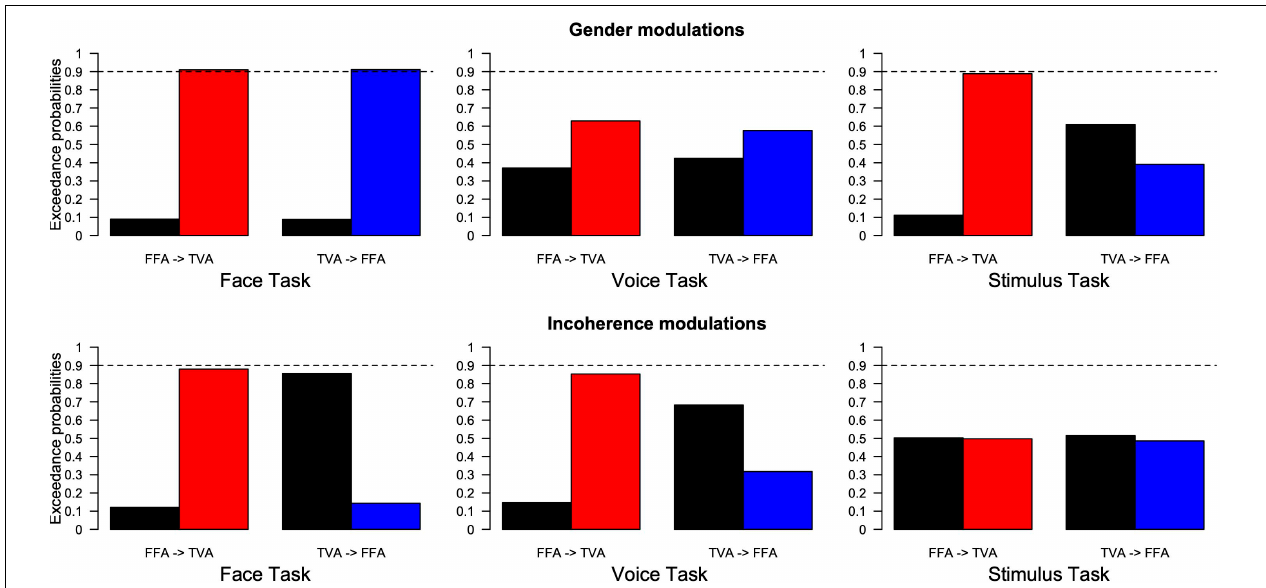
FIGURE 7 | Results of family Bayesian Model Selection for all conditions, model spaces and partitions. (Top row) Modulations of effective connectivity by face/voice gender information. (Bottom row) Modulations of effective connectivity by face/voice gender incongruence. (Left column) Modulations when subjects attend to face gender; (Middle column) when they attend to voice gender; (Right column) when they attend to stimulus gender. Within each graph, left are the respective exceedance probabilities for the family of models without modulation from FFA to TVA (black) versus the family of models with this modulation (red). Right are the exceedance probabilities for the family of models without modulation from TVA to FFA (black) versus the family of models with this modulation (blue). Probability of 0.9 is indicated as a reference for what can be considered strong evidence in favor of a family.